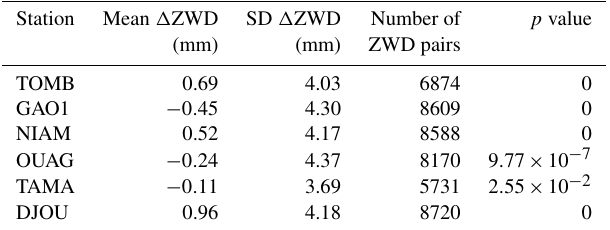
Table 2. Statistics of ZWD differences from GAMIT and GIPSY- OASIS processing solutions (GAMIT minus GIPSY-OASIS) for June to September, 2006–2008. The GIPSY-OASIS ZWD estimates were averaged over 1h intervals beforehand. The last column gives the p value of a t test for the difference of the means. Values smaller than 1 × 10 − 7 are replaced with